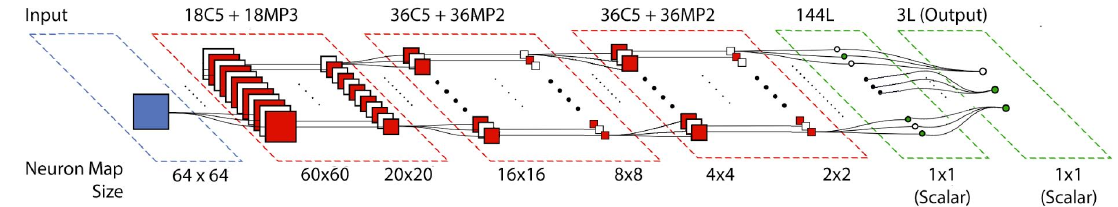
Figure 2. Convolutional Neural Network (CNN) Architecture used in the